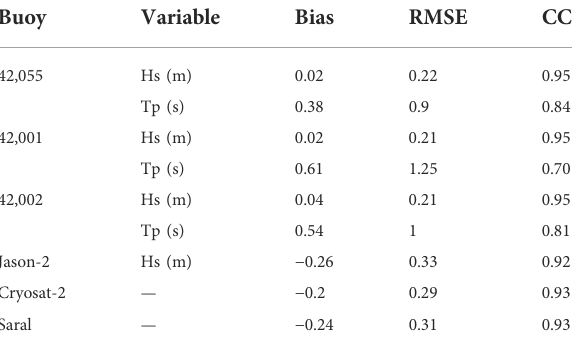
TABLE 2 Validation metrics based on NDBC buoys and satellite data. Buoy